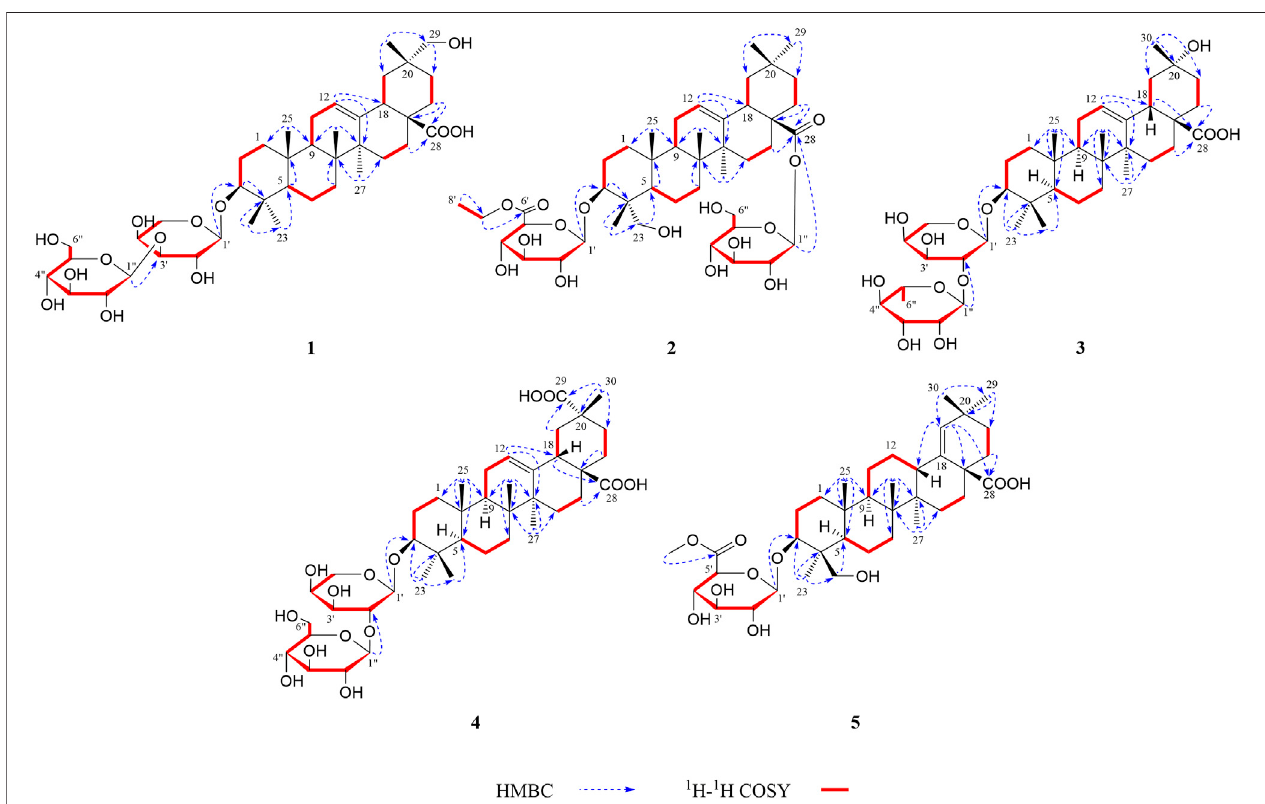
FIGURE 2 | 1 H – 1 H COSY and key HMBC correlations of compounds 1 – 5